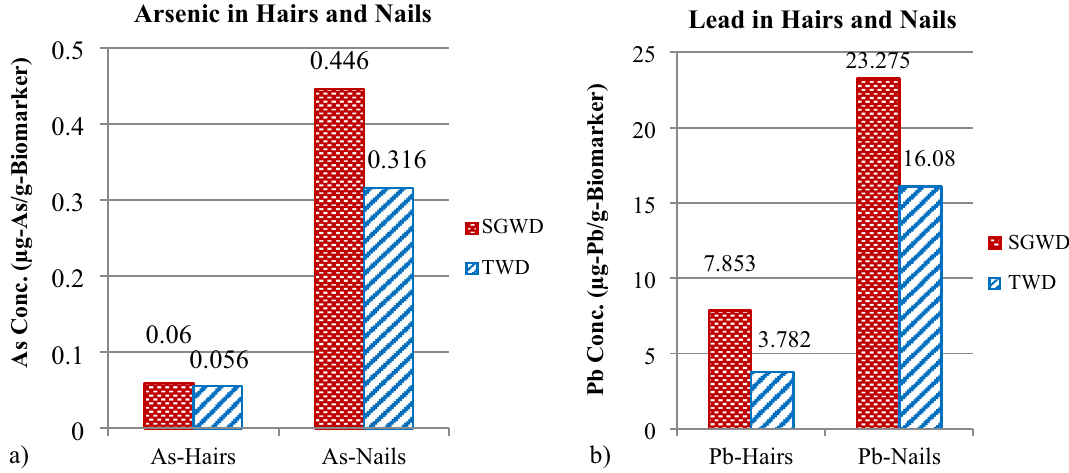
Figure 3. Comparison of the ( a ) As and ( b ) Pb levels in the hairs and finger nails from the SGWC and TWC